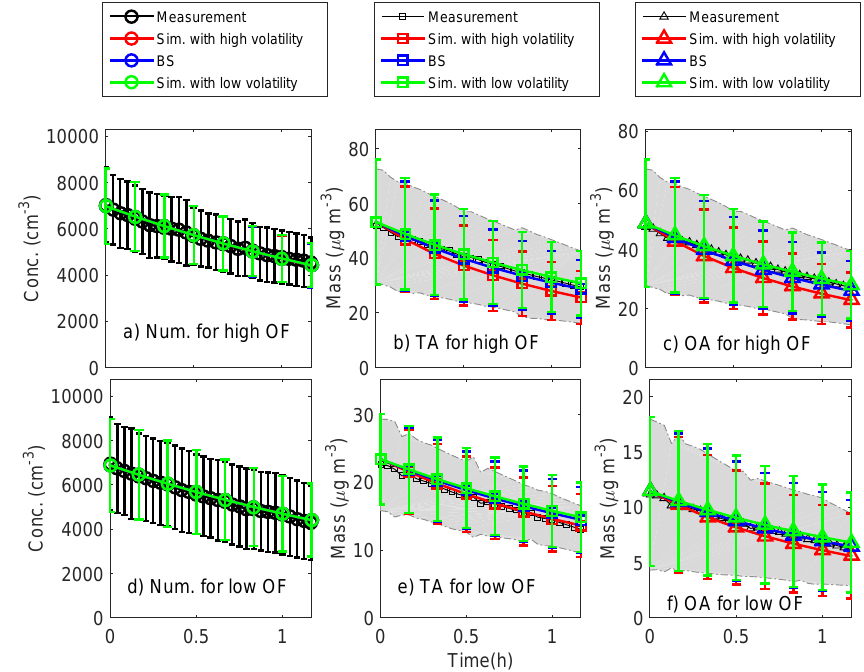
Figure 5. Similar to Fig. 2 but comparing simulations with bounding initial volatilities derived from May et al.